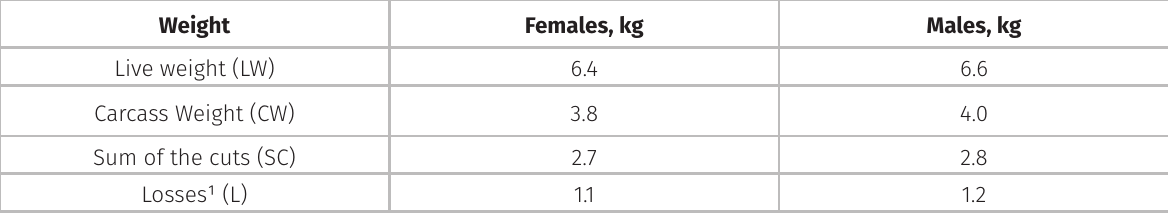
Table III. Analysis of yield of commercial cuts in relation to animals’ carcass (%), and average weight of cuts of slaughtered caimans, separated by weight category.